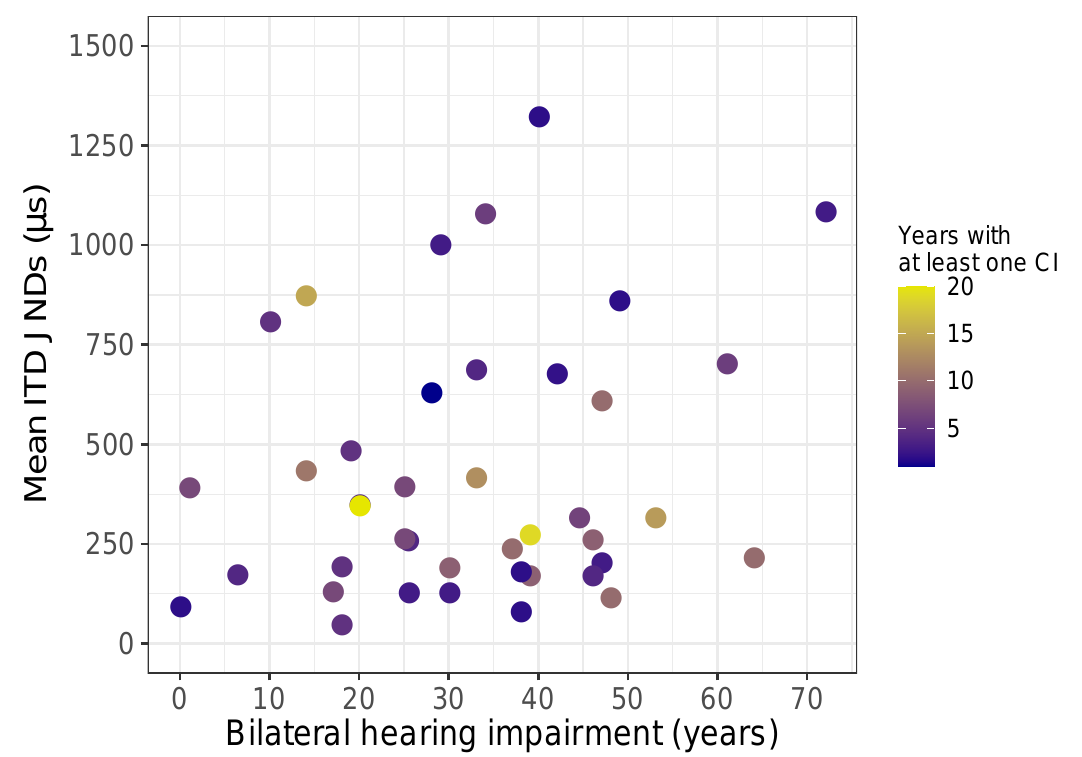
Figure 4. Shows ITD Just noticeable di ff erences (JNDs) as a function of years of bilateral hearing impairment and years with at least one CI. Blue-colored symbols indicate fewer years with at least one CI and yellow-colored symbols indicate greater years of with at least one